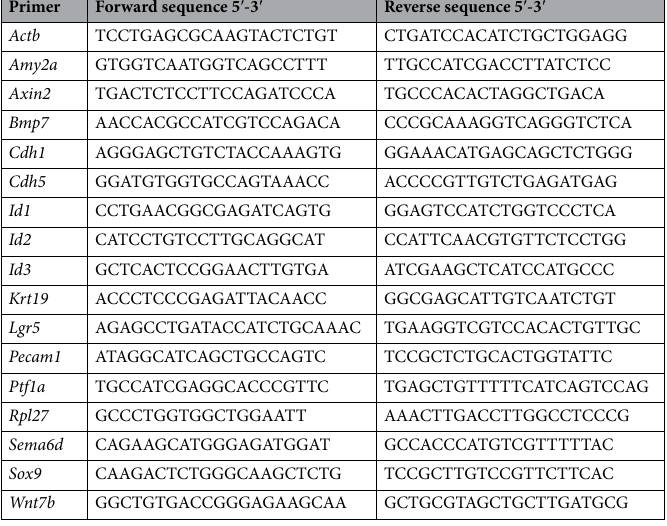
Primer Forward sequence 5 ′ -3 ′ Reverse sequence 5 ′ -3